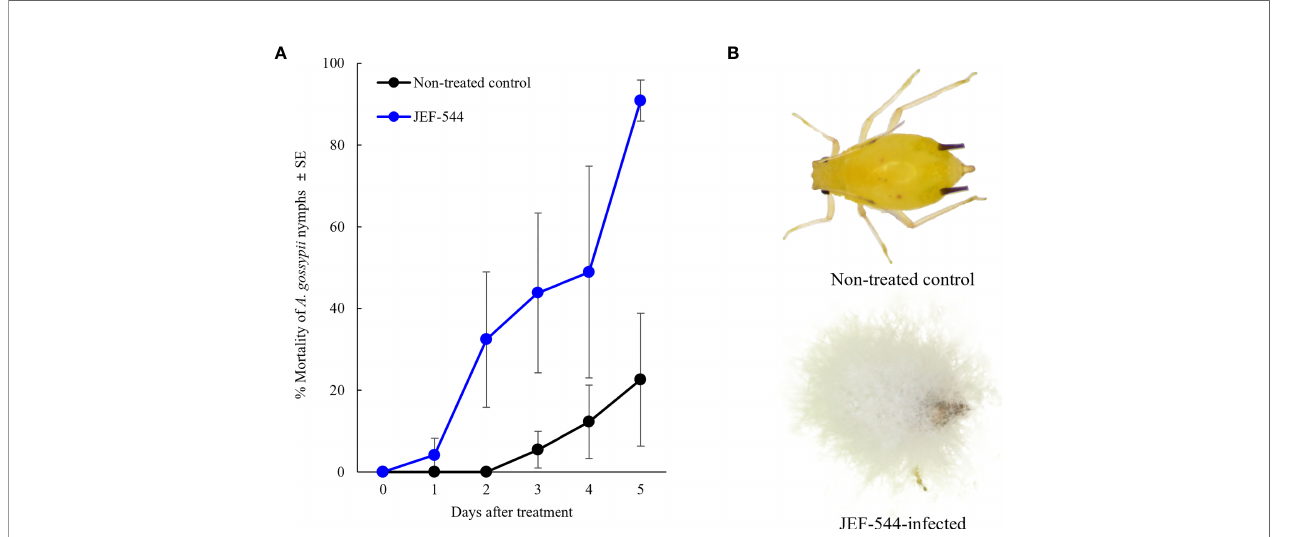
FIGURE 1 | Virulence of B bassiana JEF-544 against cotton aphid in laboratory conditions. (A) Mortality of cotton aphids against B bassiana JEF-544 (F 1,11 = 7.173, p = 0.12) and (B) Non-infected and JEF-544-infected aphid nymphs 6 days after